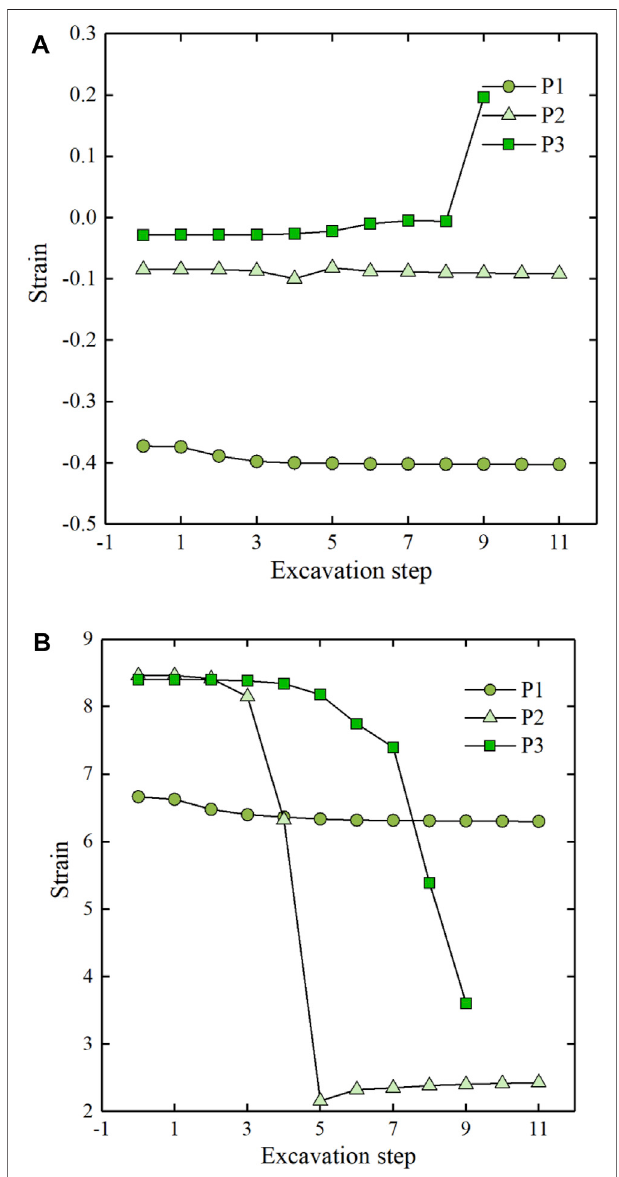
FIGURE10|(A) Crossriverwardstresschangeprocess. (B) Cross-river to strain change process.